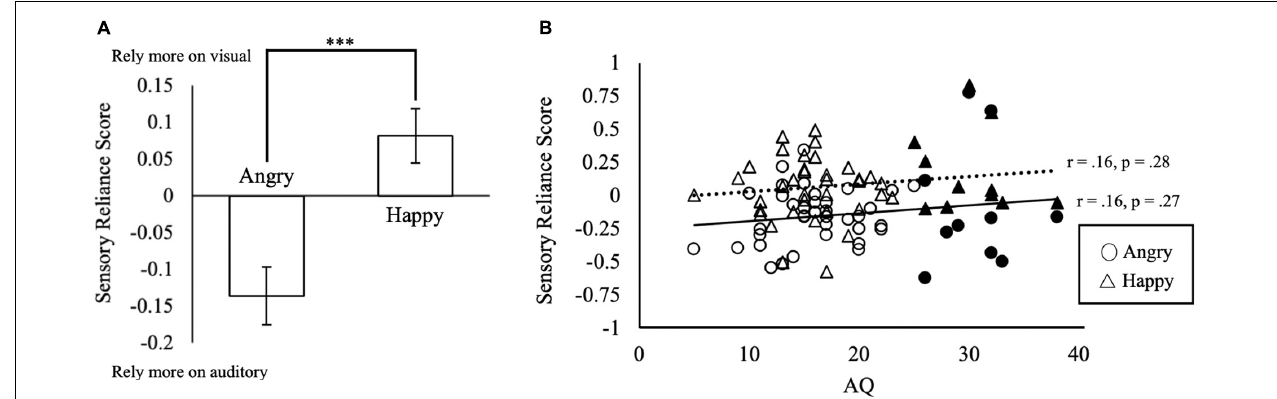
FIGURE 4 | Sensory reliance in multisensory integration. (A) Sensory reliance score by emotion conditions. Positive values in sensory reliance score indicate a higher reliance on visual input, negative values indicating a higher reliance on auditory input during multisensory emotion perception. ∗∗∗ p < 0.001. The error bars indicate standard errors of mean (SEM). (B) Relationship between AQ and sensory reliance score. Solid triangles and circles indicate the responses from the subjects with AQ ≥